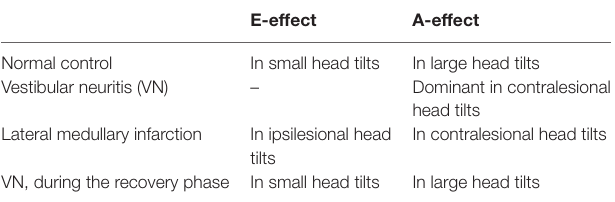
TaBle 3 | Summary of the shifts of subjective visual vertical during head tilts.